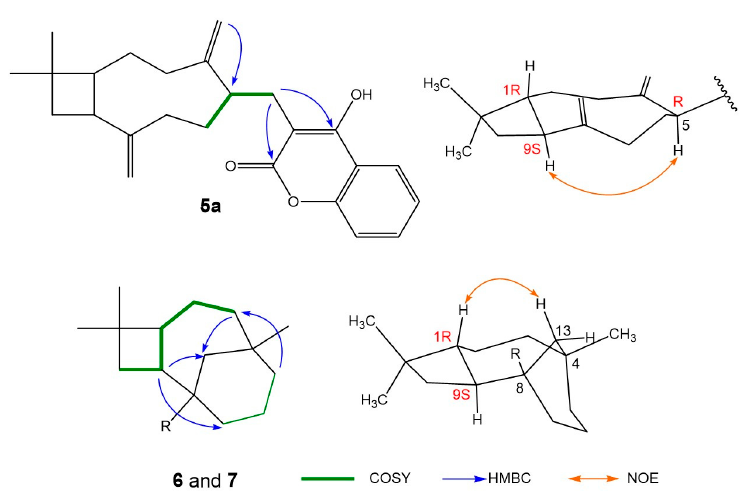
Figure 3. Selected 2D NMR correlations of compounds 5a , 6 , and 7 .